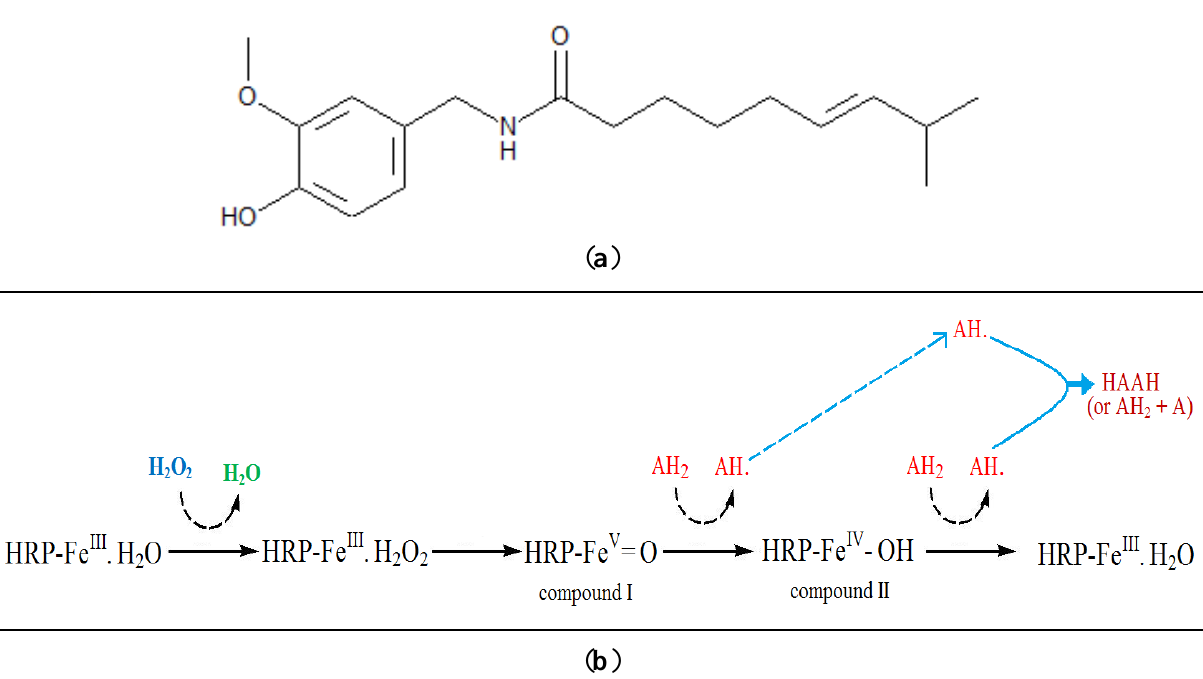
Figure 1. The structure of capsaicin ( a ); and the proposed reaction mechanism of peroxidase with capsaicin and hydrogen peroxide ( b ). AH radical from the hydrogen donor (capsaisin or phenolic compounds); HRP = Horseradish peroxidase; HAAH = polymerized